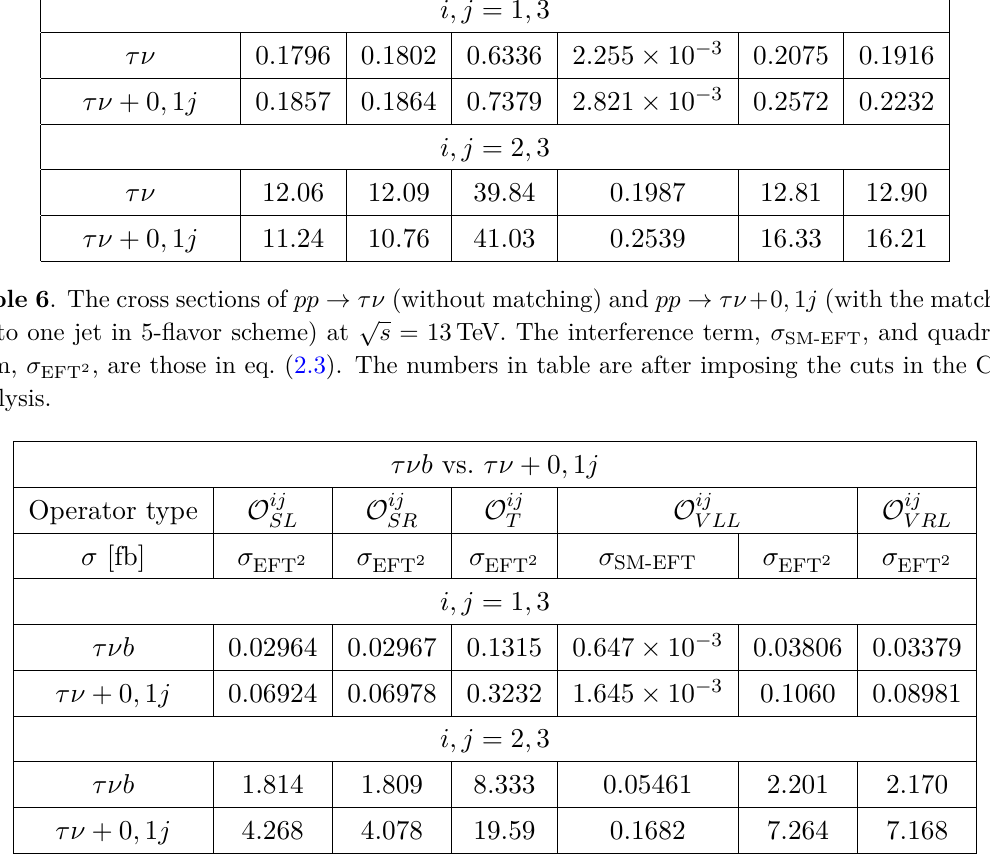
Table 7 . The cross sections of pp → τνb (without matching) and pp → τν + 0 , 1 j (with the √ matching up to one jet in 5-flavor scheme) at s = 13 TeV. The interference term, σ SM-EFT , and quadratic term, σ , are those in eq. (2.3). The numbers in table are after imposing the cuts in EFT 2 eqs. (3.5) and